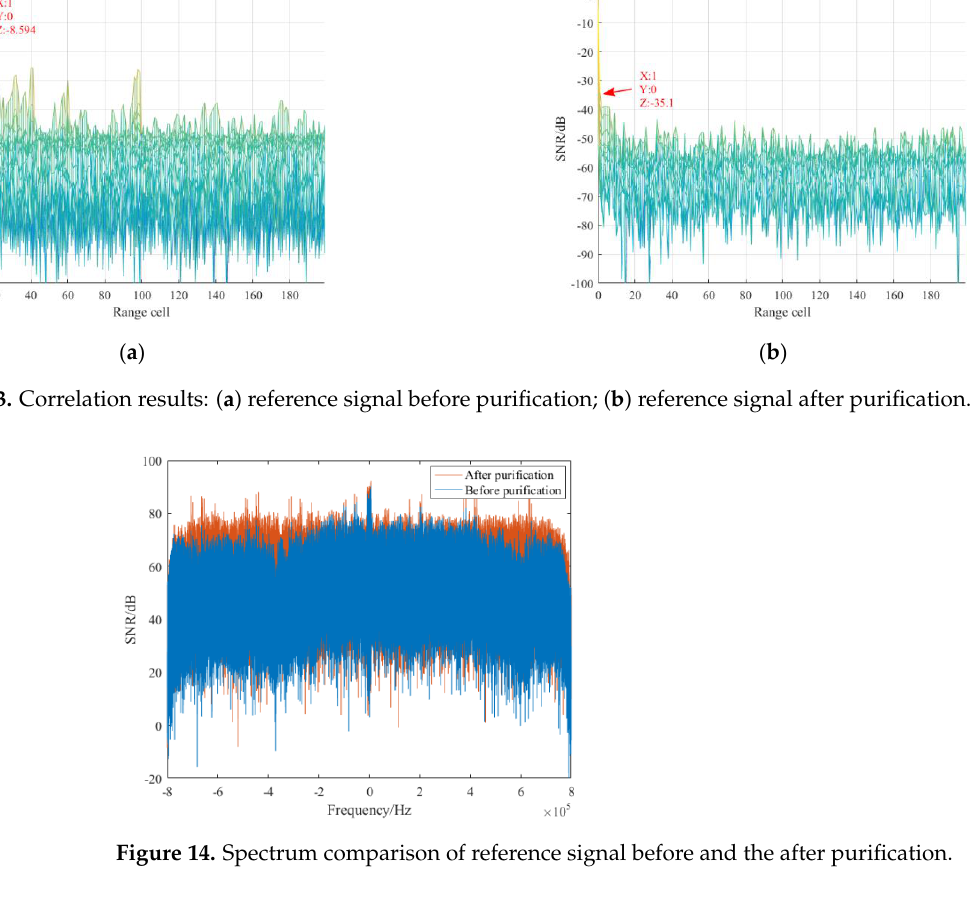
Table 3. Clutter suppression ratio of different purification method.